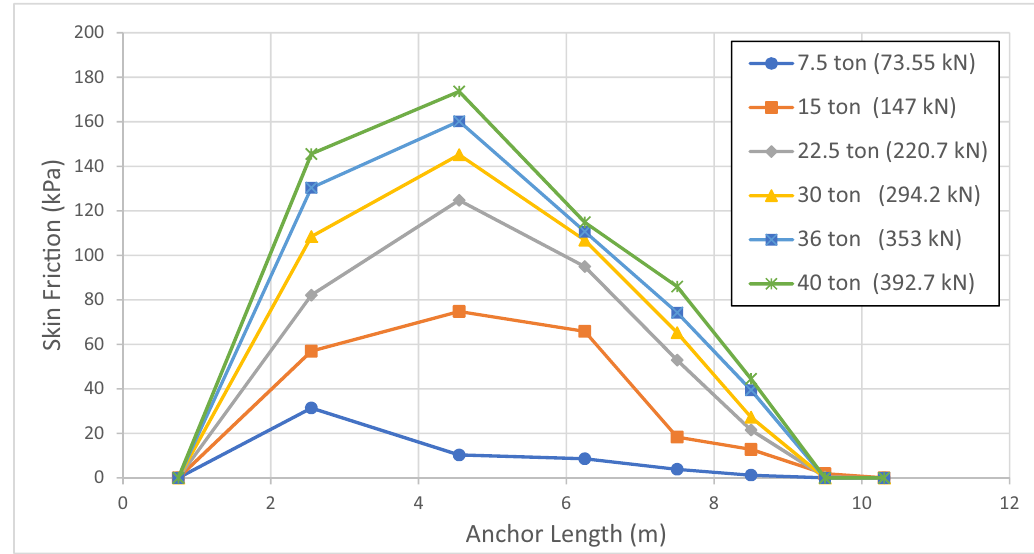
Figure 22: Skin friction stress along anchor length.